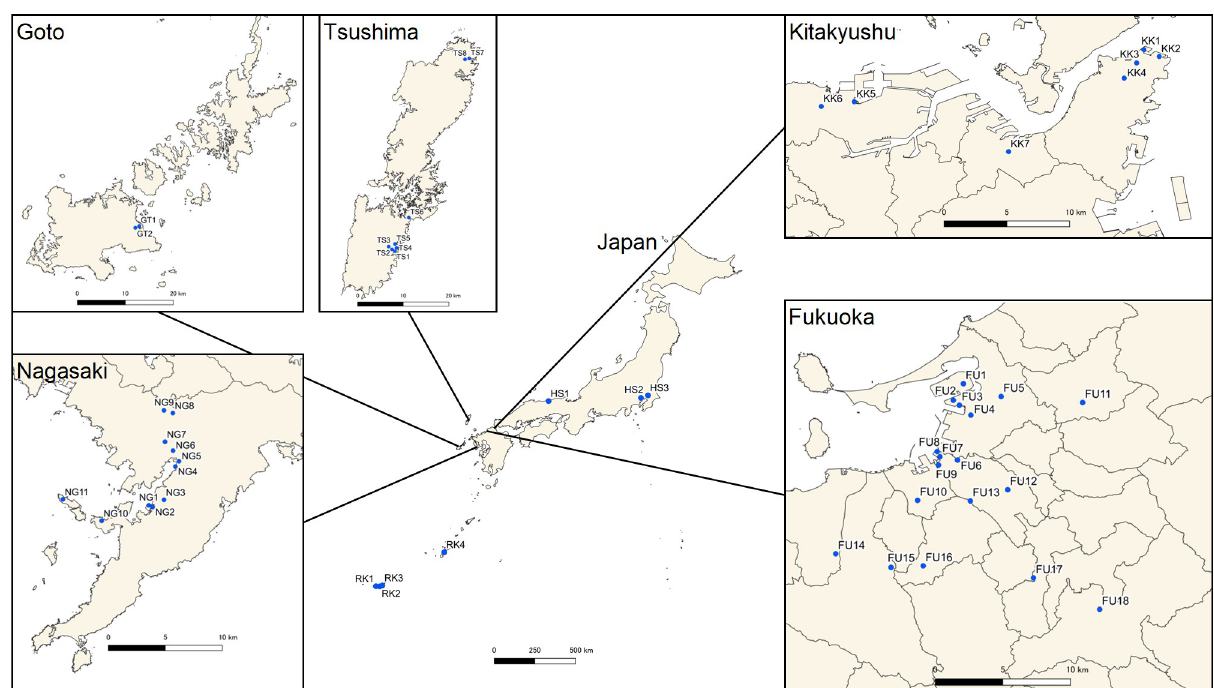
Fig 1. Collection sites of Ae . albopictus in Kyushu. Created by processing Free vector and raster map data @ naturalearthdata.com and National Land Numerical Information (Administrative Area Data) @ Ministry of Land, Infrastructure, Transport and Tourism, Japan (https://nlftp.mlit.go.jp/ksj/gml/